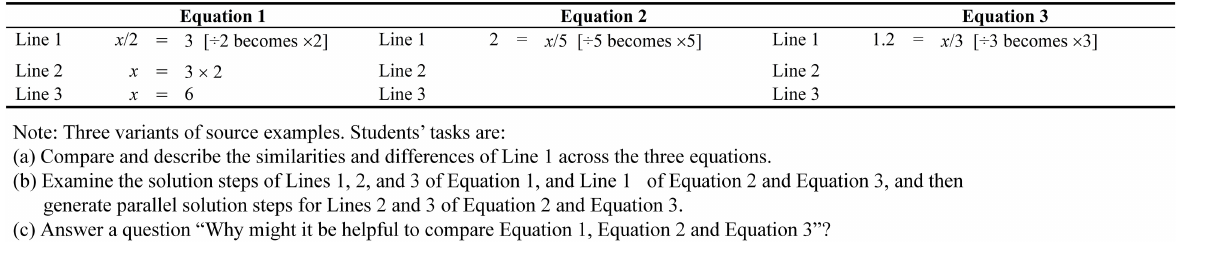
FIGURE 1 | Three variants of source